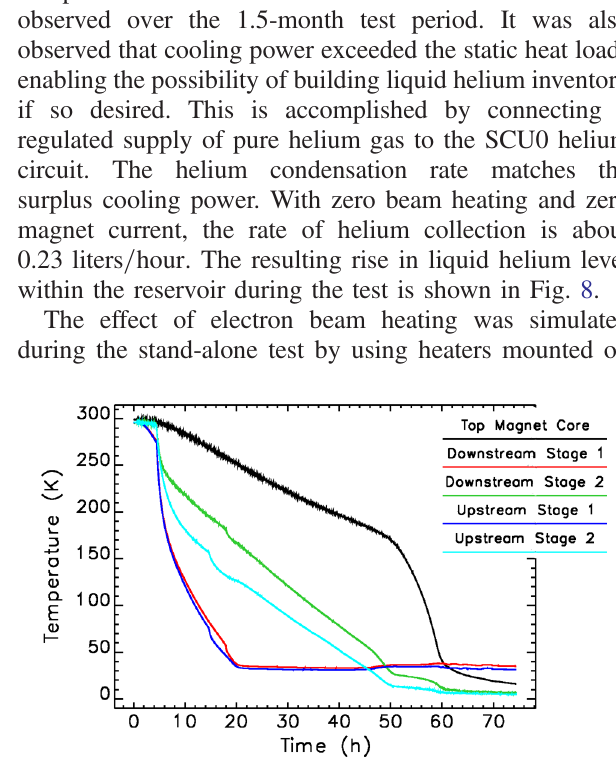
FIG. 7. SCU0 4 K cryocooler stage and top magnet core temperatures during the cool down